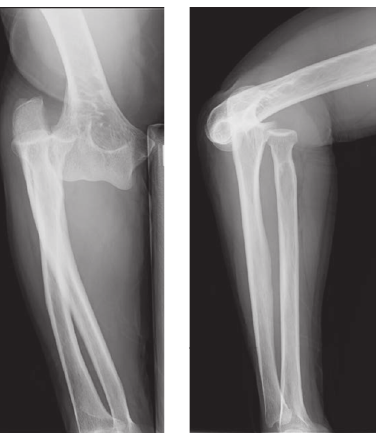
Figure 1: Anteroposterior and lateral radiographs of the elbow revealed lateral convergent displacement of the radius and ulna relative to the humerus without fracture signs.